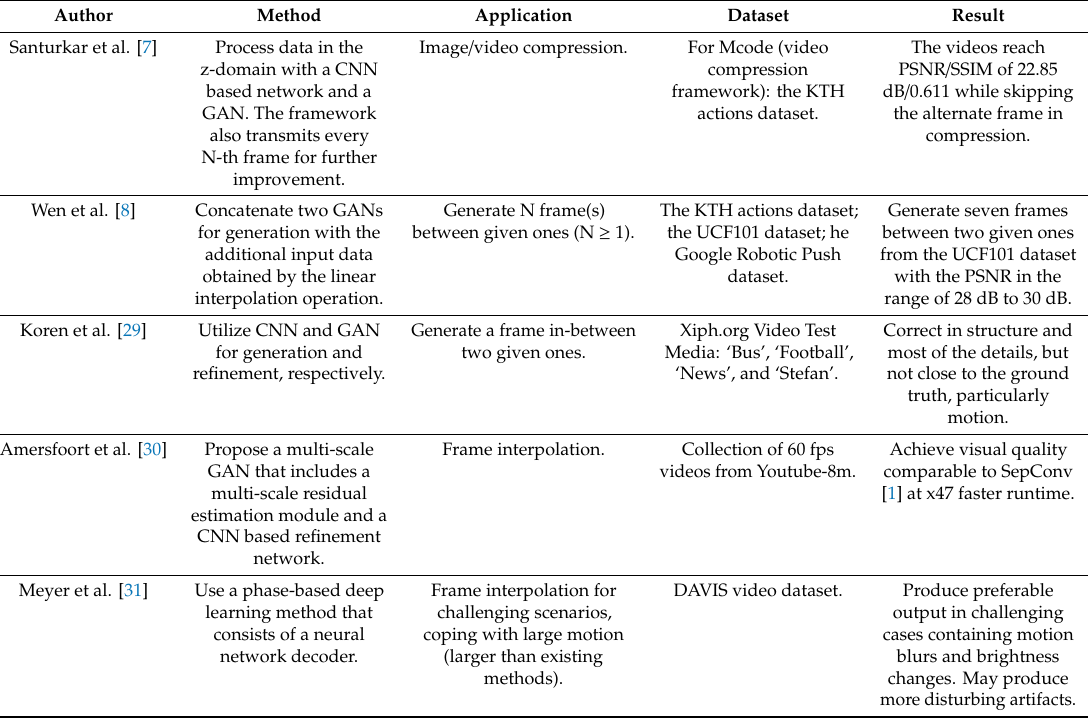
Table 1. Deep learning-based approaches for frame